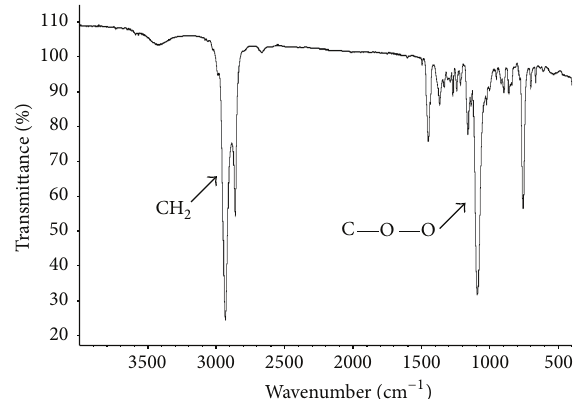
Figure 2: IR spectrum of poly(CHO). Polymerization catalyzed by 0.2 g of H 3 PW 12 O 40 at 40 ∘ C during 3 hours in CH 2 Cl 2